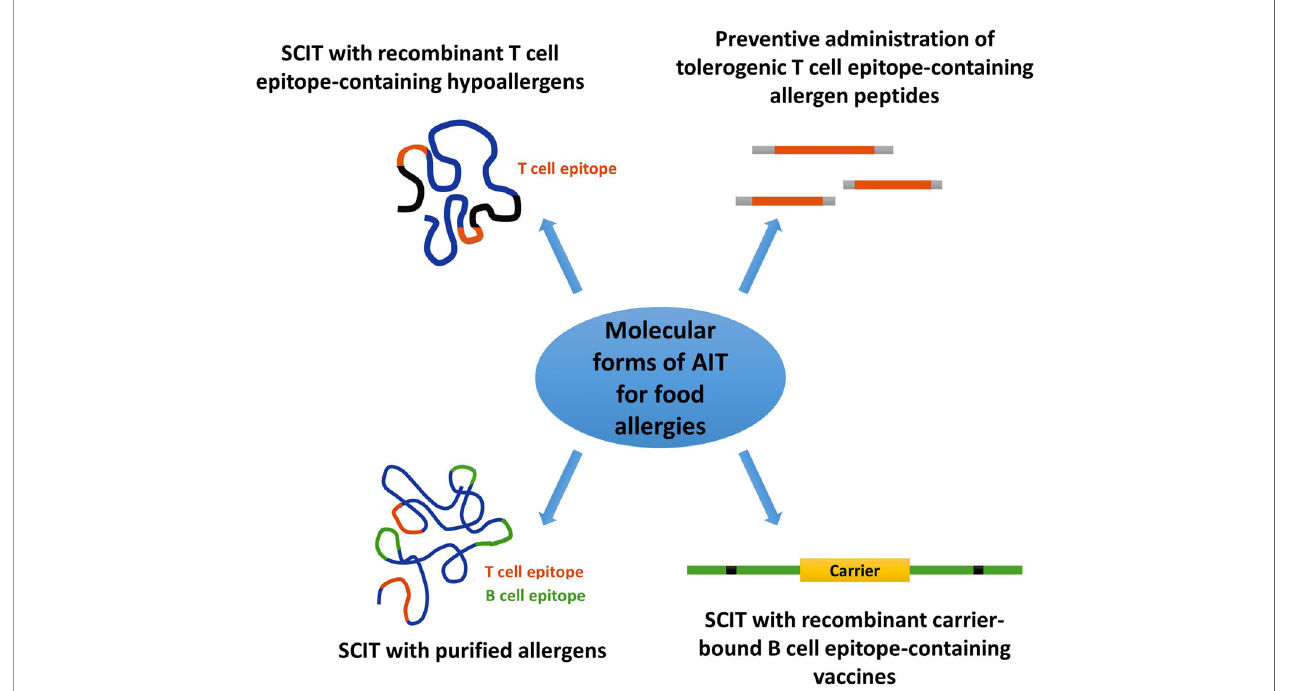
FIGURE 4 | Molecular forms of AIT which can be used for SCIT approaches in nut